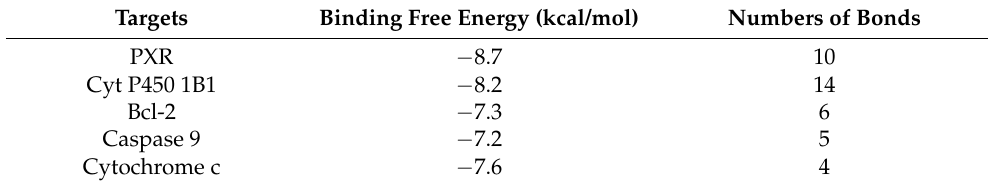
Table 4. Molecular docking mode for Cyanidin- 3 - O -glucoside with PXR, Bcl-2, Caspase 9, and Cytochrome